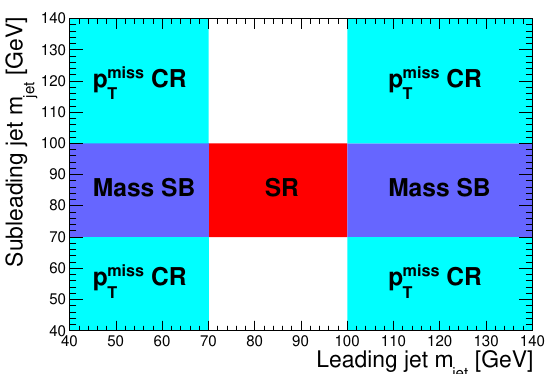
Figure 3 . De(cid:12)nition of the search and control regions in the plane of subleading vs. leading jet mass. The search region (red central box), with both m values lying within the Z signal window, de(cid:12)nes jet the acceptance for potential signal; the leading-jet mass sideband (dark blue), with subleading jet within and leading jet outside the signal window, is used to measure the background normalization; the p miss CR (light blue), with both leading- and subleading-jet m values lying outside the signal T jet window, is used to derive the p miss shape in the search T